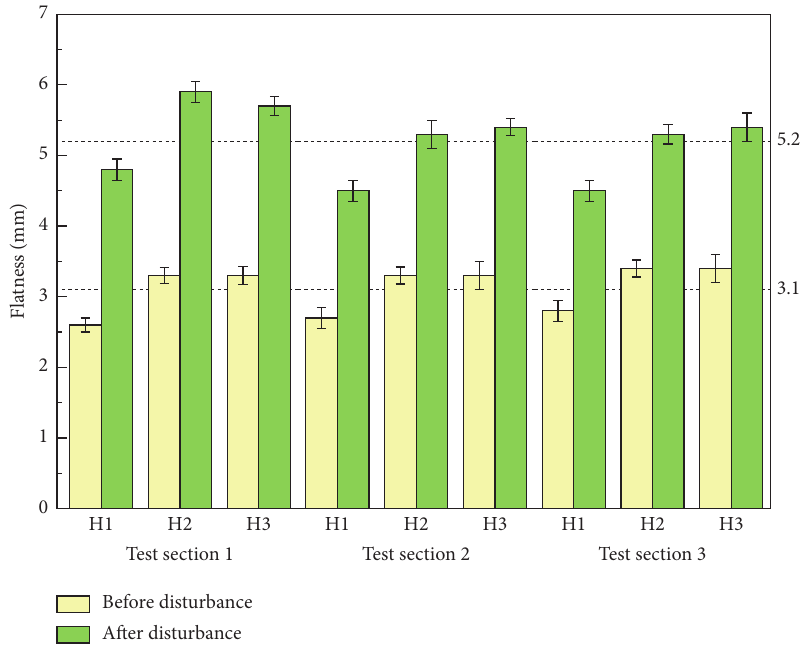
Figure 10: Transverse evenness test results. Table 8: Quality control standards considering evenness disturbance.